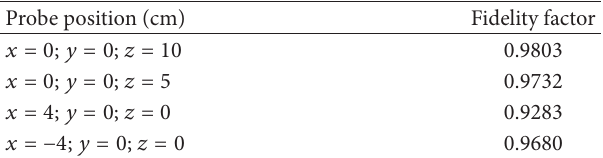
T 1: Simulated �delity factor for the proposed twin antenna. Probe position (cm) Fidelity